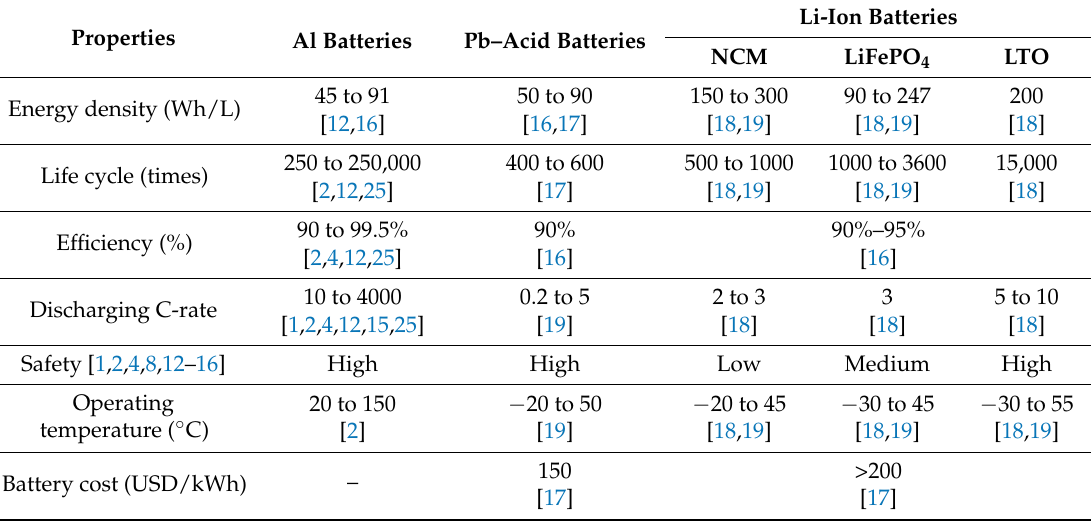
Table 1. Comparison of Al batteries, Pb–acid batteries, and Li-ion